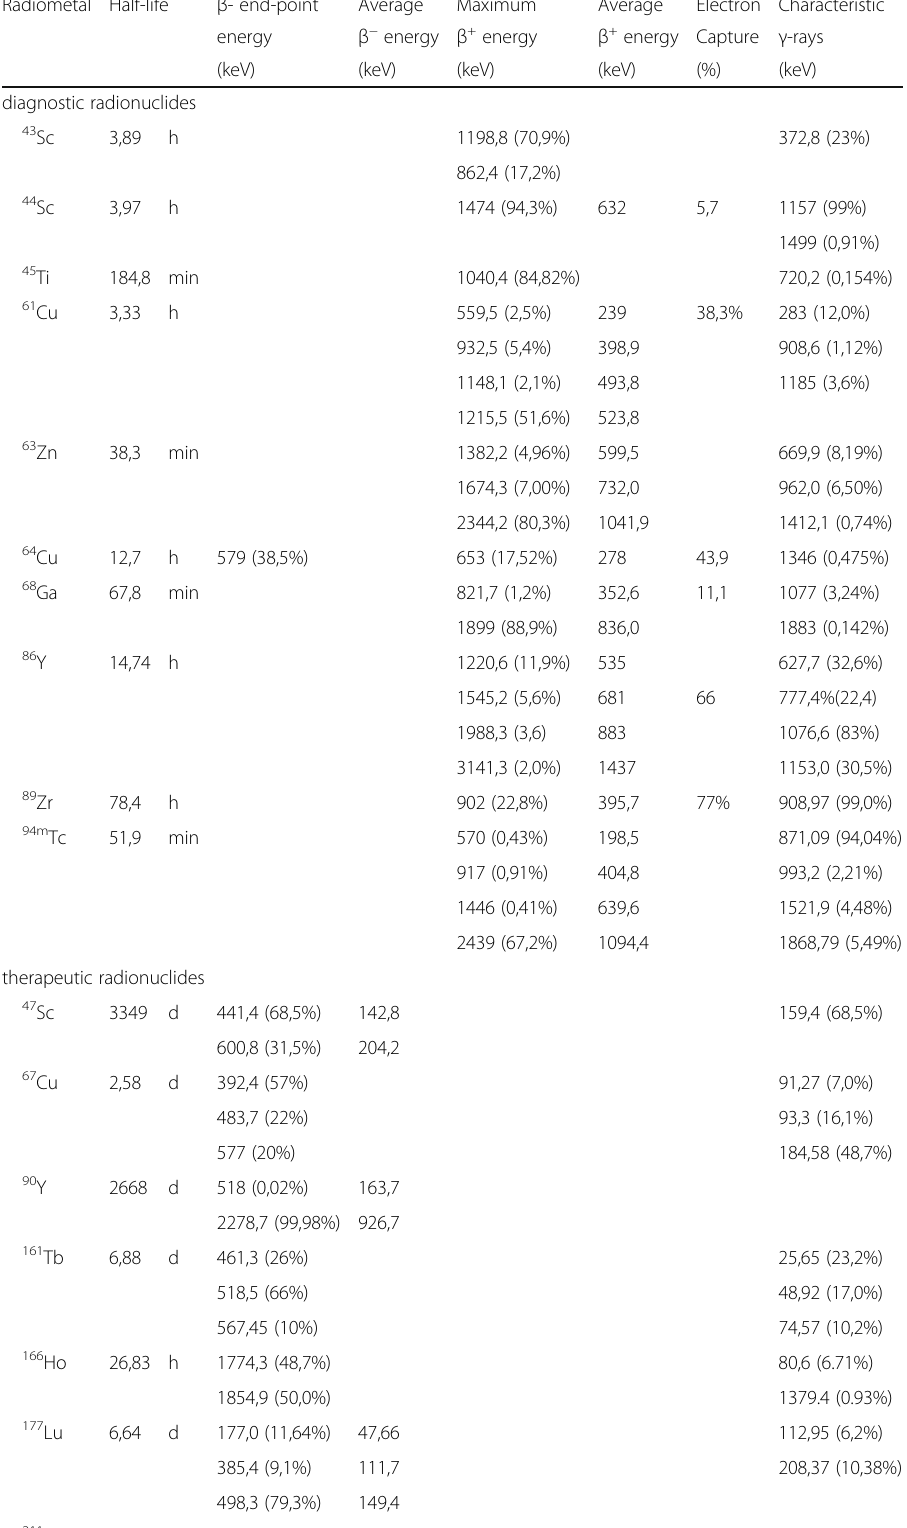
Table 1 Emerging radiometals and their nuclear